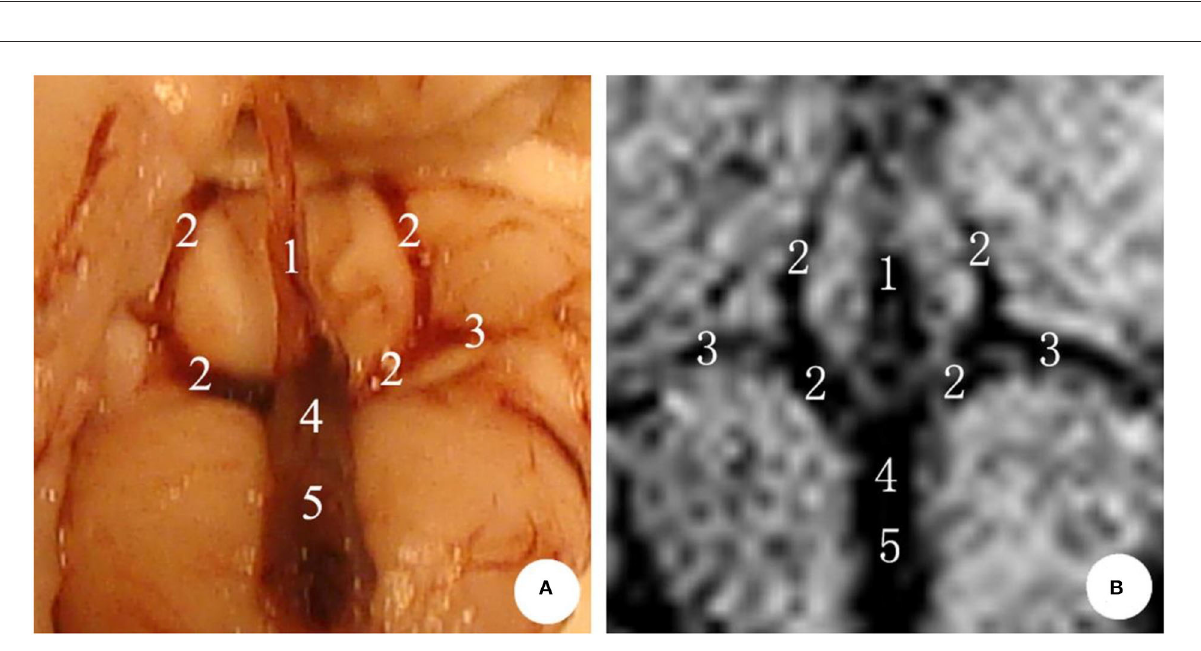
In the SAH group, the mean diameter of the internal cerebral vein was (0.53 ± 0.05) mm on 0 d; the mean diameter was (0.43 ± 0.08) mm on 1st d after modeling, and the difference was